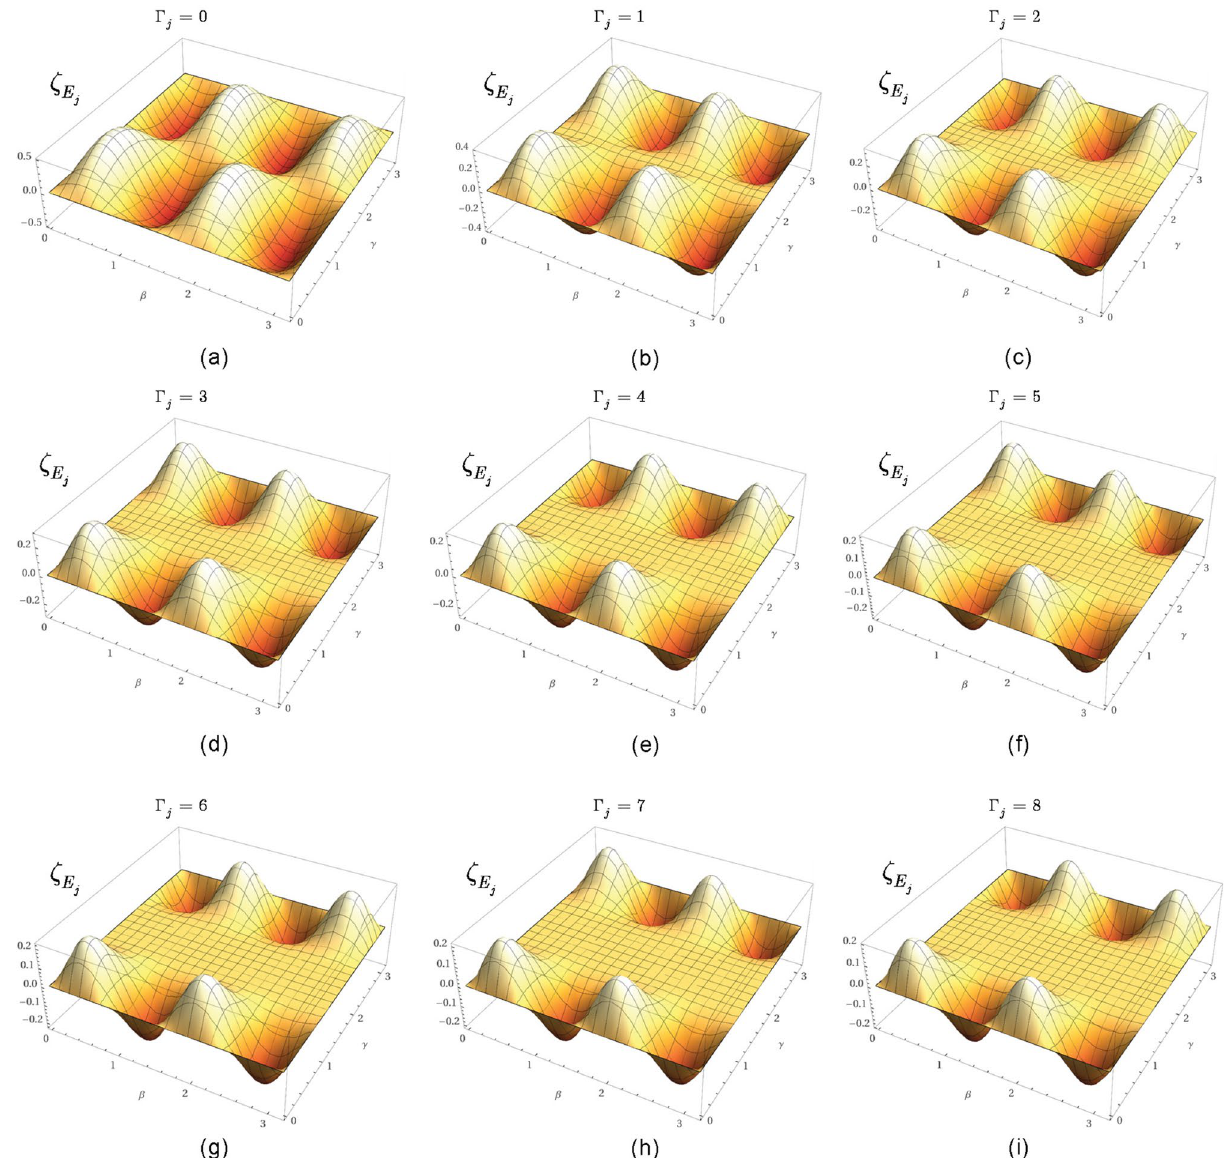
1 γ jk , for different Ŵ j values ( γ jk is set for 2 = 1 ( c ) Ŵ j 2 ( d ) Ŵ j = =